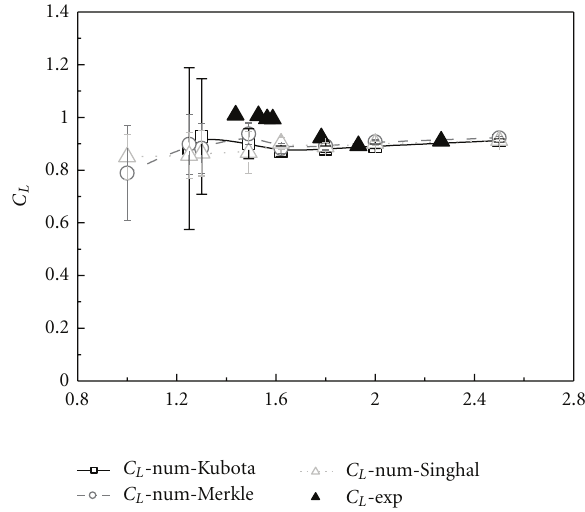
Figure 17: Comparisons of the measured and predicted lift coe ffi cients ( C L ) for various cavitation numbers. Re = 750,000, α = 6 ◦ , and n = 3. V ∞ = 5 m/s,